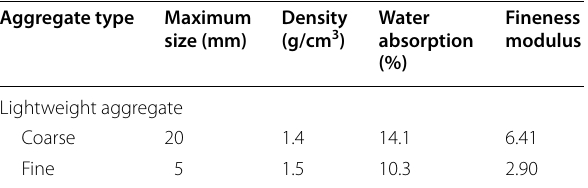
Table 1 Physical properties of